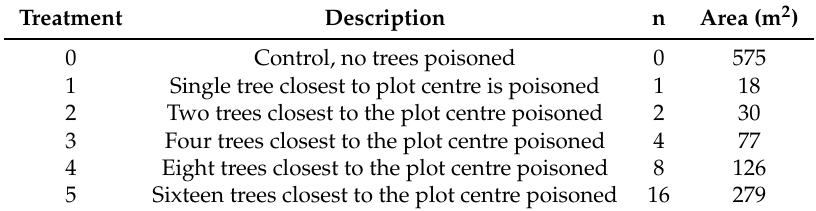
Figure 1. Location of the study site within New Zealand with examples of the broadband multispectral imagery from RapidEye ( a ) and the UAV MicaSense Red Edge camera ( c ) with both images showing the trial area at a 1:5000 scale. The normalised spectral response curves for the RapidEye ( b ) and the MicaSense RedEdge ( d ) sensors are also shown based on data provided by the sensor developers. Table 1. Experimental treatments used in the study. The number of trees subjected to herbicide application in the treatment and the mean cross-sectional area occupied by the canopy of the treated trees is shown. This table is modified from